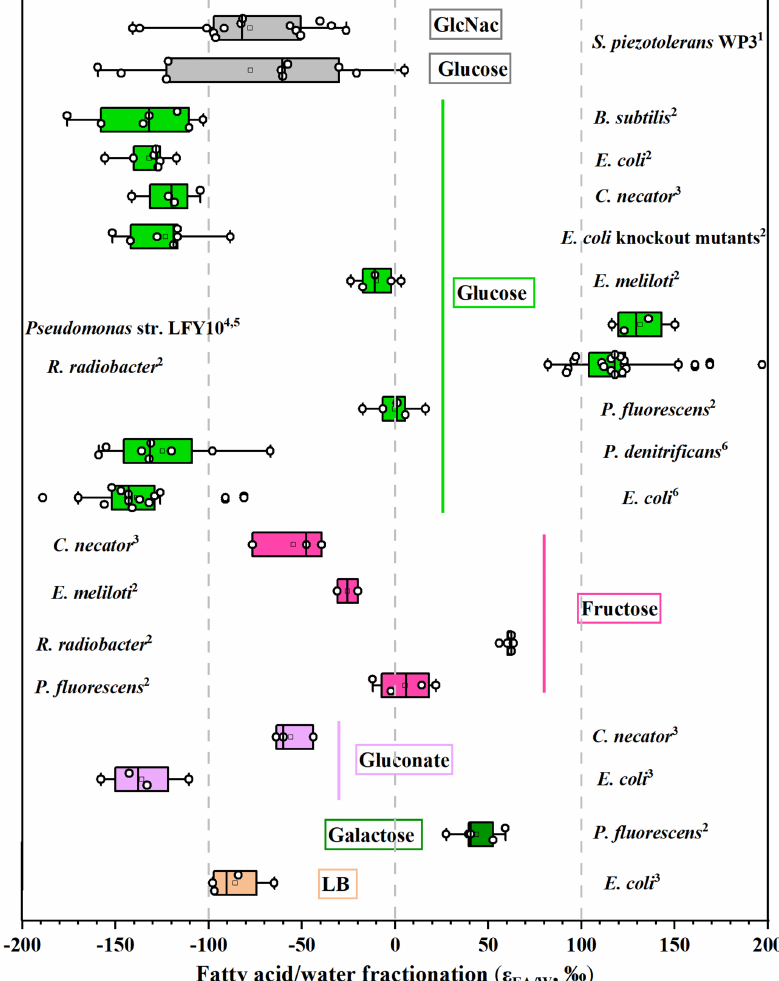
Figure 4. Compilation of measured hydrogen isotope fractionations growing on sugars. For each organism, bars represent the range of values for all individual fatty acids. The vertical line is the average value. Data sources: 1 this study; 2 Wijker et al. (2019); 3 X. Zhang et al. (2009); 4 , 5 Heinzelmann et al. (2015a, b); 6 Osburn et al. (2016).